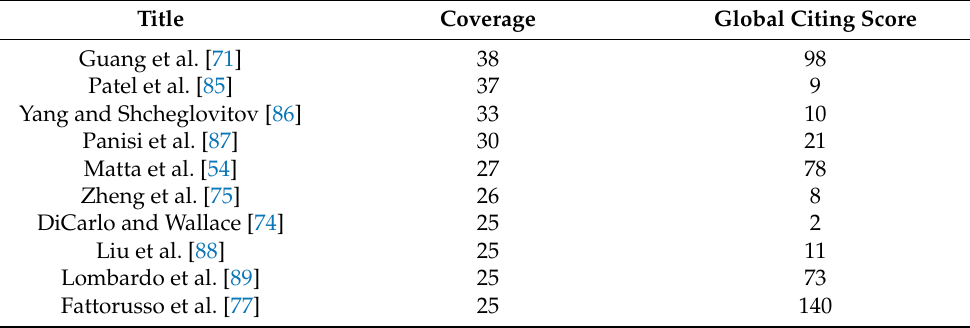
Table 4. Top 10 citing papers in Cluster #1 identified using